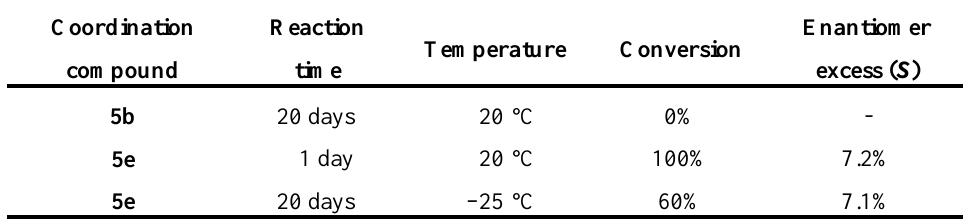
Table 3. Michael addition reaction of ethyl 2-oxocyclohexanecarboxylate with but-3-en- 2-one catalysed by coordination compounds 5b and 5e